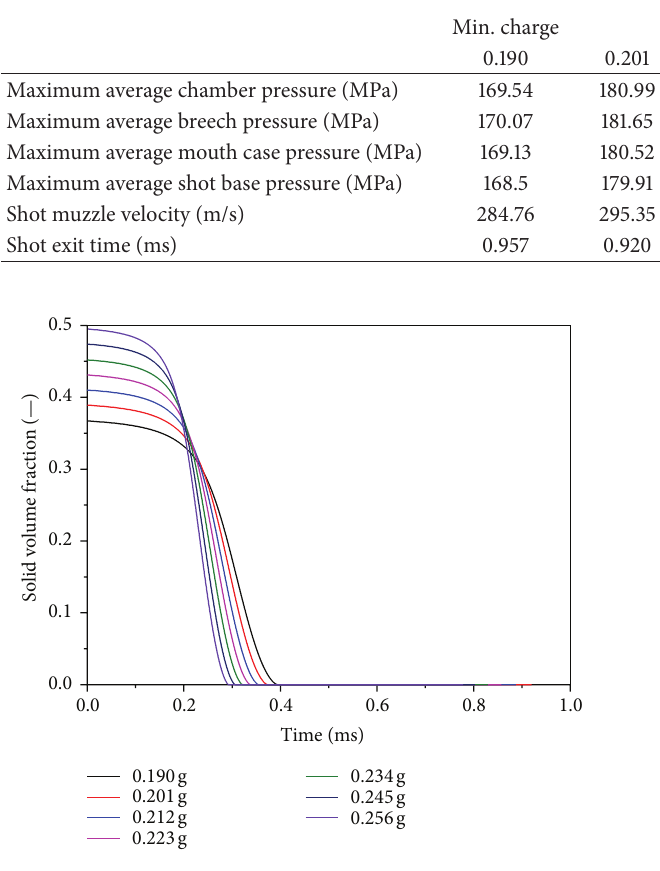
Figure 13: Solid volume fraction-time history for for 𝑚 𝑝 ∈ [0.190g– 0.256 g].